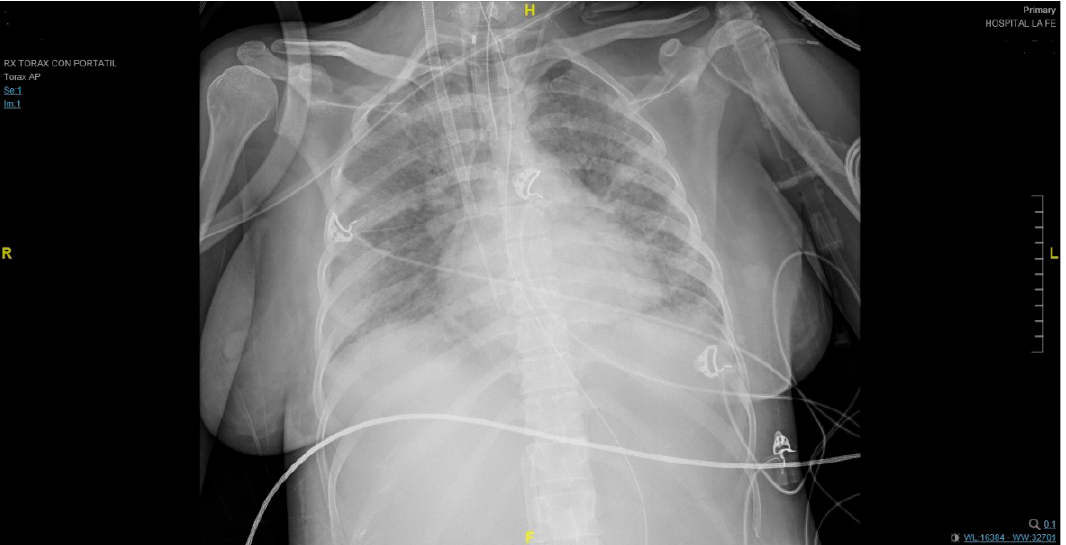
Figure 1. An anteroposterior chest X-ray revealed extensive bilateral areas of consolidation and the endotracheal tube at 2 cm of carina.